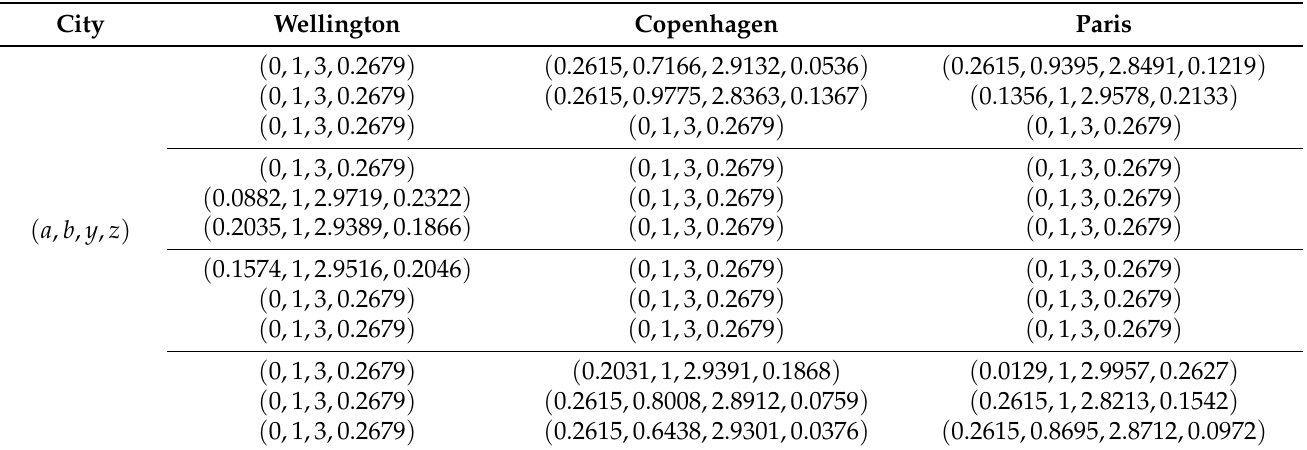
Table 2. Installation specification with respect to the south meridian altitude of each city. The azimuth angle is 35 π /36. Note that the data is aligned by month from the top (January) to the bottom (December).